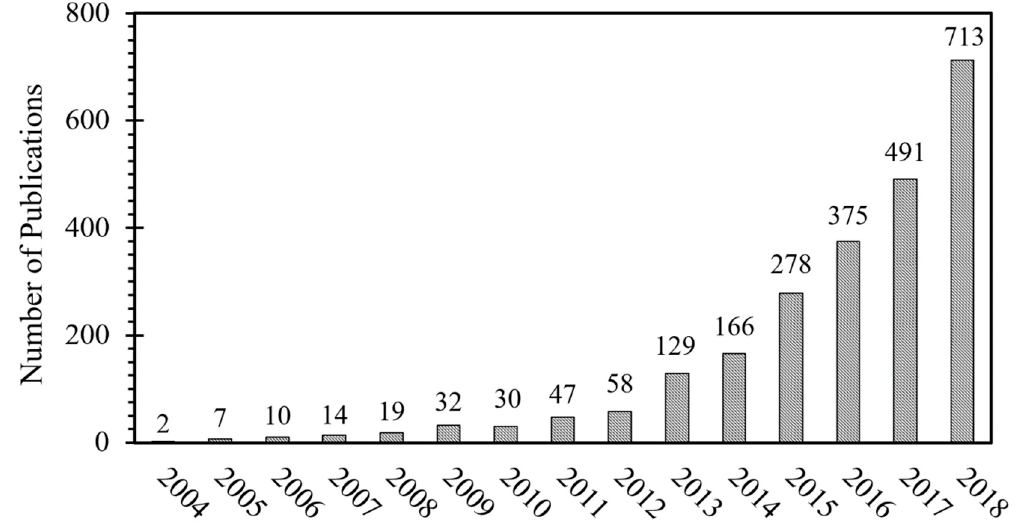
Figure 1. Number of publications on multi ‐ principal element (MPE) alloys per year.